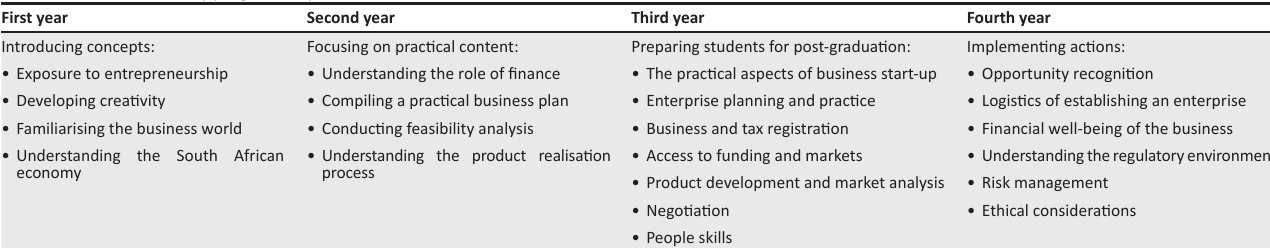
TABLE 2: Course content by programme year. First